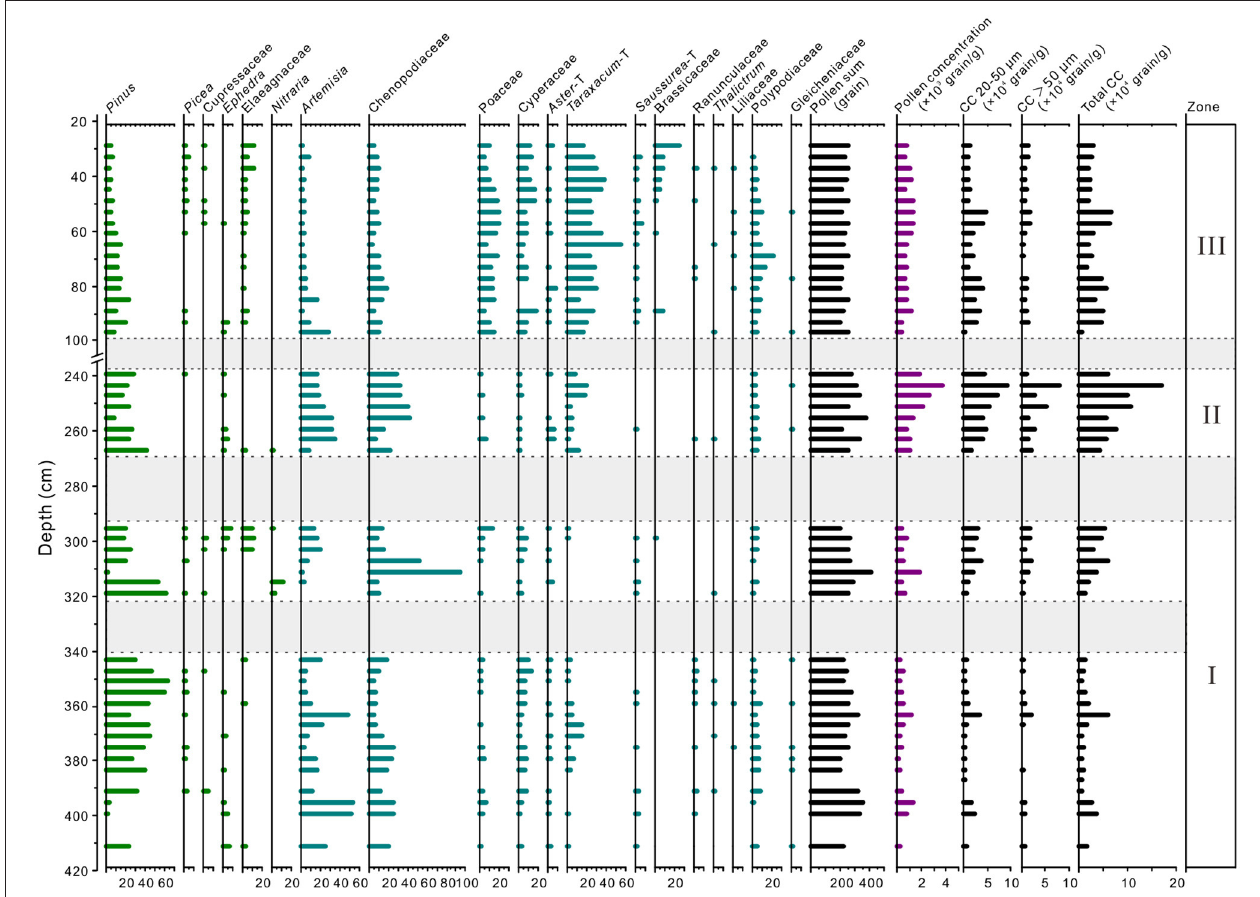
FIGURE 7 | Percentage of main pollen taxa and charcoal concentration (CC) at section